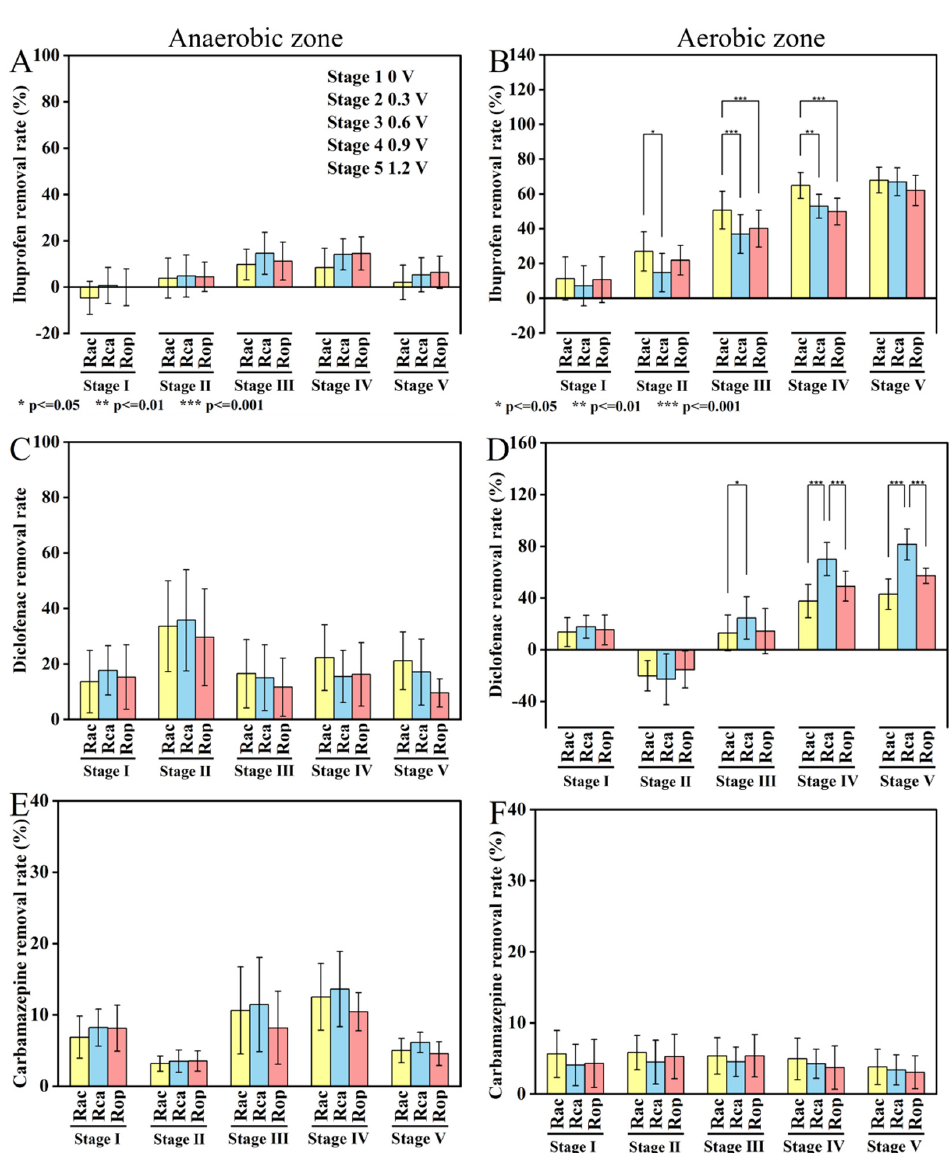
Figure 3. Ibuprofen ( A , B ), diclofenac ( C , D ), and carbamazepine ( E , F ) removal performances in anaerobic and aerobic zones of AO − UBER chambers.